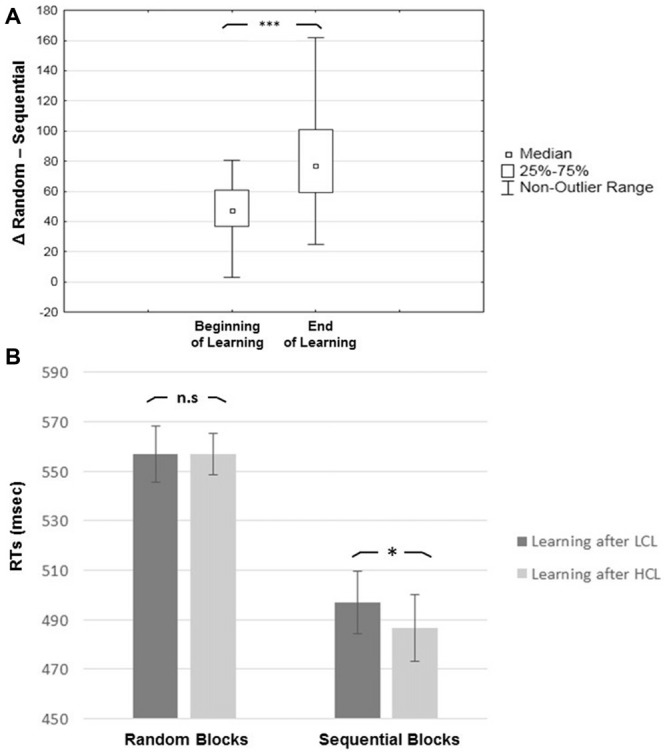
Learning effects. (A) Learning effect (RTs for random minus sequential blocks). (B) Type of Block by Condition interaction, showing that the positive effect of CF is present for sequential but not random blocks. Error bar represent one standard deviation from the mean; Asterisks indicate p-value significance after Tukey post hoc correction: *p < 0.05; **p < 0.01 and ***p < 0.001. n.s: non-significant.